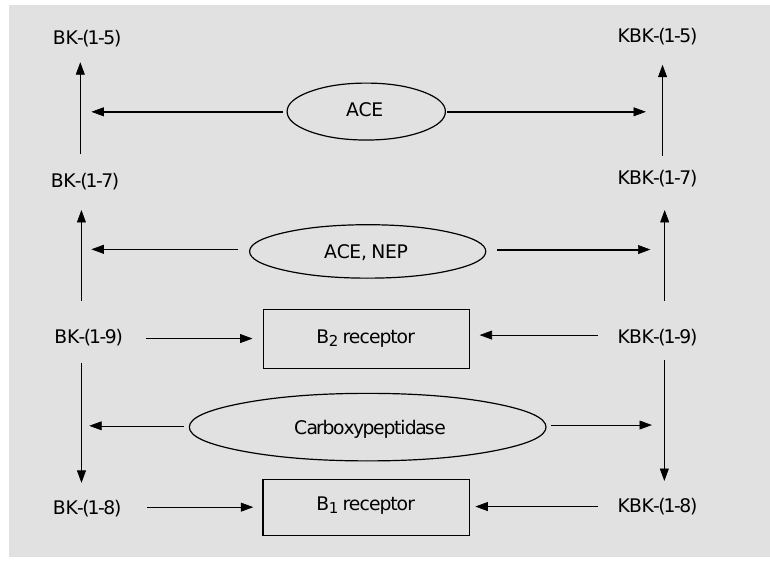
Figure 2 - Kinin peptides and kinin receptors. Whereas bradykinin [BK-(1-9)] and kallidin [KBK- (1-9)] are more potent agonists of the B 2 receptor, BK-(1-8) and KBK-(1-8) are more potent agonists of the B 1 receptor. ACE, Angiotensin converting enzyme; NEP, neutral endopepti- dase; BK, bradykinin; KBK, Lys